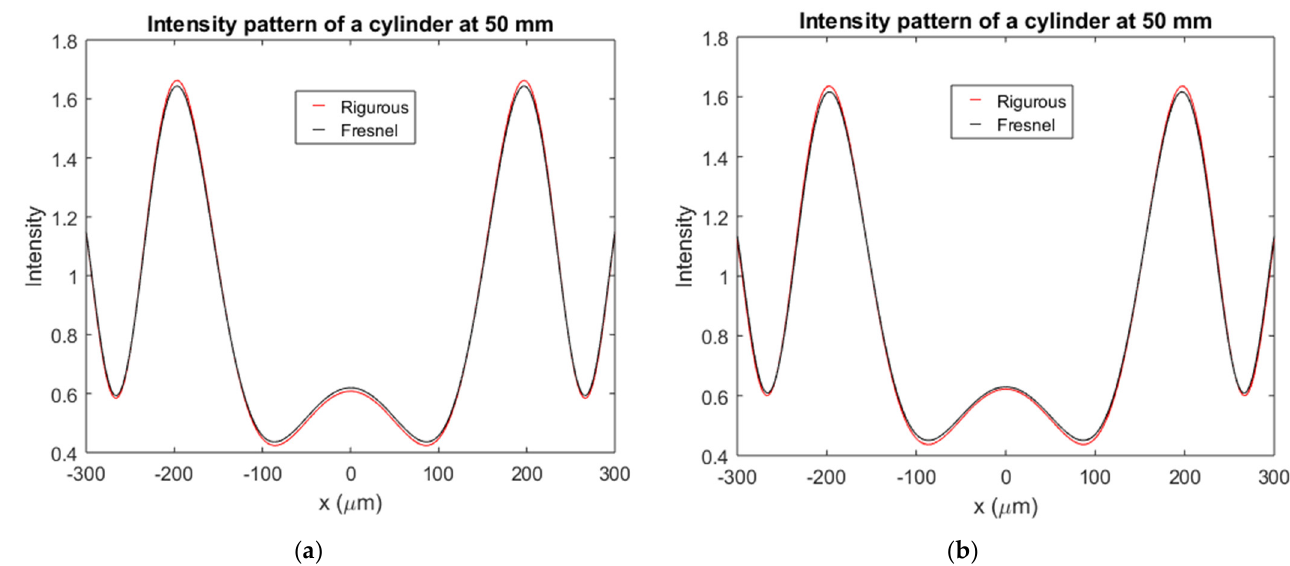
Figure 7. Intensity of the diffraction pattern as a function of the distance to the center of the diffraction pattern for a dielectric cylinder with internal radius a = 30 µm: ( a ) with refractive index n = 1.85; ( b ) with refractive index n = 3.4. The intensities were calculated assuming that the diffraction pattern was measured at an axial distance z = 50 mm from the fiber.